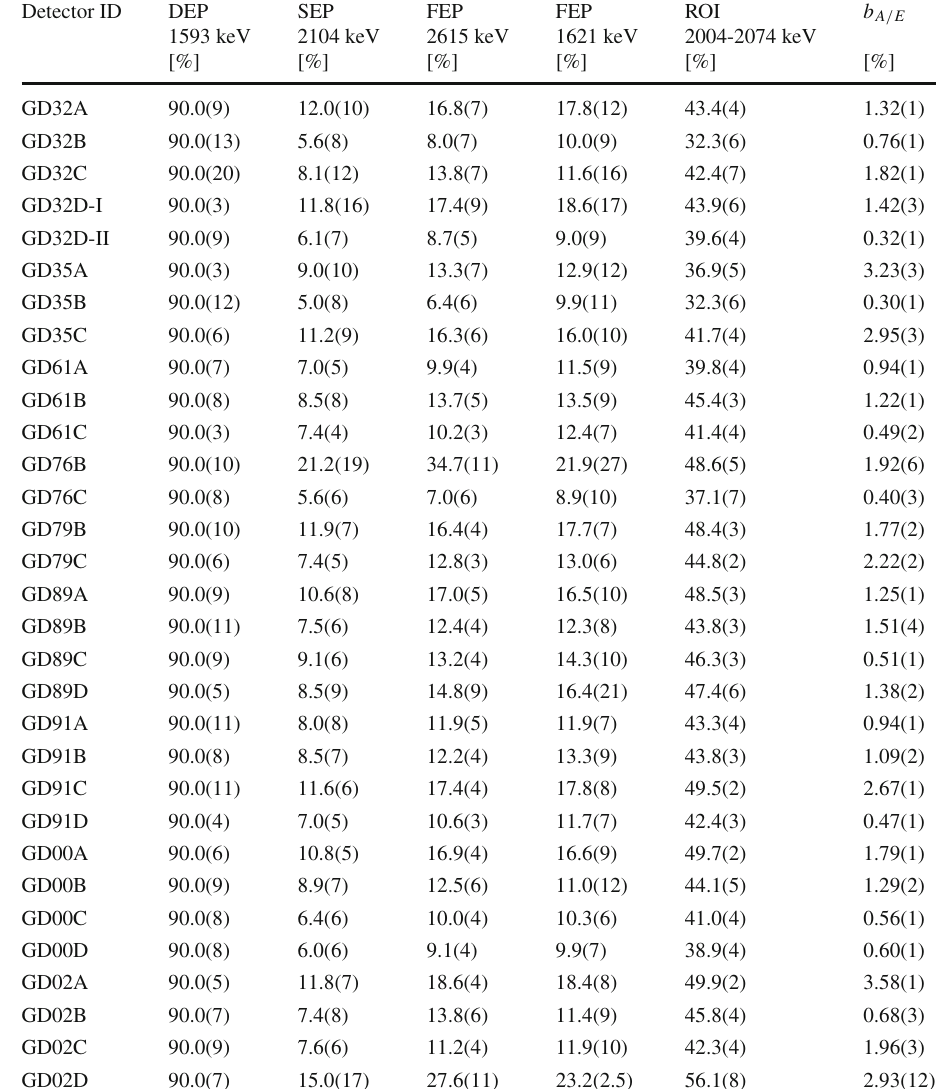
Table 10 Gamma-ray background survival fractions and the DEP A / E resolution b A / E ( 228 Th) for the 30 Gerda Phase II BEGe detectors operated under vacuum conditions. In the case of the detector GD32D, the pulse shape performance was measured before (I) and after (II) reprocessing. The uncertainty of the survival fraction includes the statistical and the